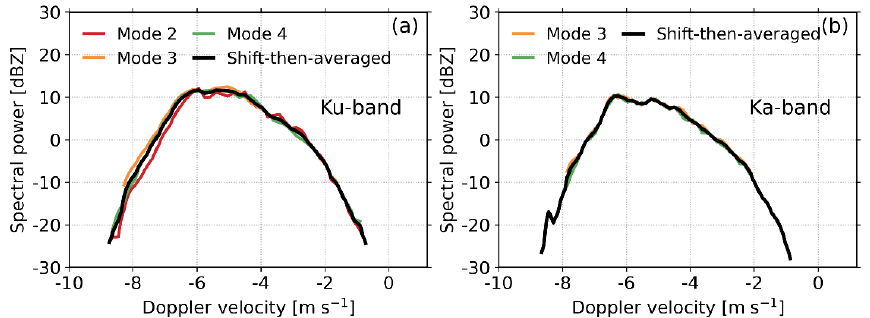
Figure 11. (a) Ku-band Doppler velocity spectra from modes 2, 3, and 4 recorded on 6 June 2020 at 22:52:08LST at 2.34km. The merged Doppler spectrum was derived from the Doppler spectra recorded at modes 2, 3, and 4 after shifting and averaging. Note that Ku-band radar observations at mode 1 were not used due to the power loss during coherent integration. (b) The same as in (a) but for Ka-band, and observations at modes 3 and 4 were used.